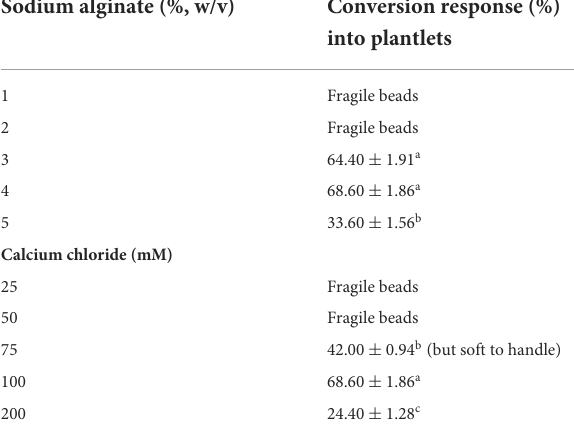
TABLE 5 Effect of Na 2 -alginate + CaCl 2 · 2H 2 O on conversion of encapsulated NS (means ± SE) (8 weeks after culture). Sodium alginate (%, w/v)